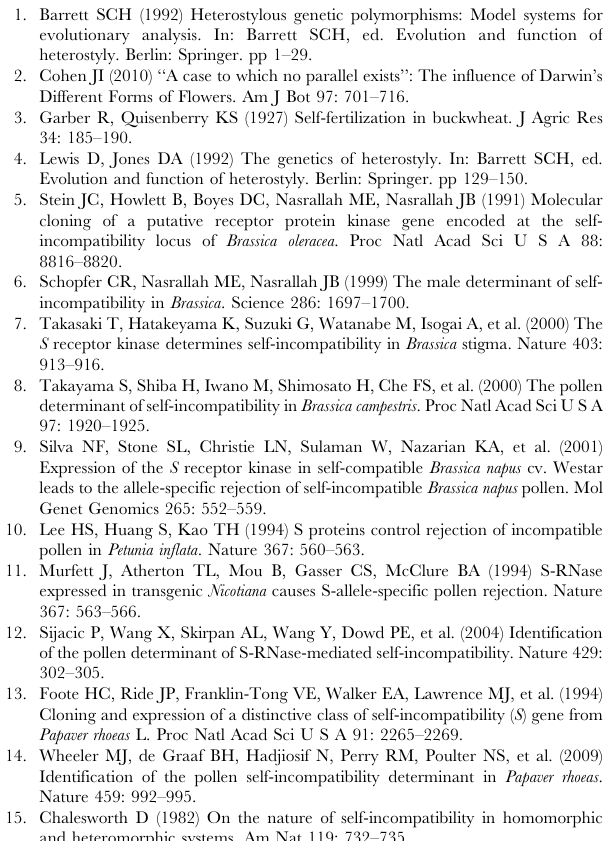
Figure S4 PCR survey of SSG2 in 47 buckwheat landraces and modern cultivars. The numbering corre- sponds to that shown in Table S2. L, long-styled plant. S, short- styled plant. N, negative control. M, XL DNA Ladder 100 bp (APRO). (TIF) Figure S5 Neighbor-Joining trees of 20 buckwheat alleles of (A) S-ELF3 and (B) SSG2 . The trees were obtained using MEGA5 and drawn to scale, with branch lengths indicated below. The p -distance estimated from 4,087 and 755 nucleotide sites was used for S-ELF3 and SSG2 , respectively, and the complete deletion option was applied. The sum of branch lengths was 0.010 for the S-ELF3 gene tree. (TIF) Figure S6 Breakdown of association between the pres- ence of S-ELF3 and floral phenotype by recombination. Contiguous and dotted lines indicate the frequency of individuals with a positive marker at a locus neighboring S -locus in short ( S x ) and long-styled ( L x ) plants, respectively, under the assumption that the initial population (0 th generation) contains only two types of individuals, i.e., long-styled plants, which are homozygotes of the S-ELF3 2 – s haplotype and short-styled plants, which are heterozygotes of the S-ELF3 + – S and S-ELF3 2 – s haplotypes, with equal frequency. (TIF) Table S1 Contigs obtained by in silico subtraction and pairs of primers used for RT-PCR.